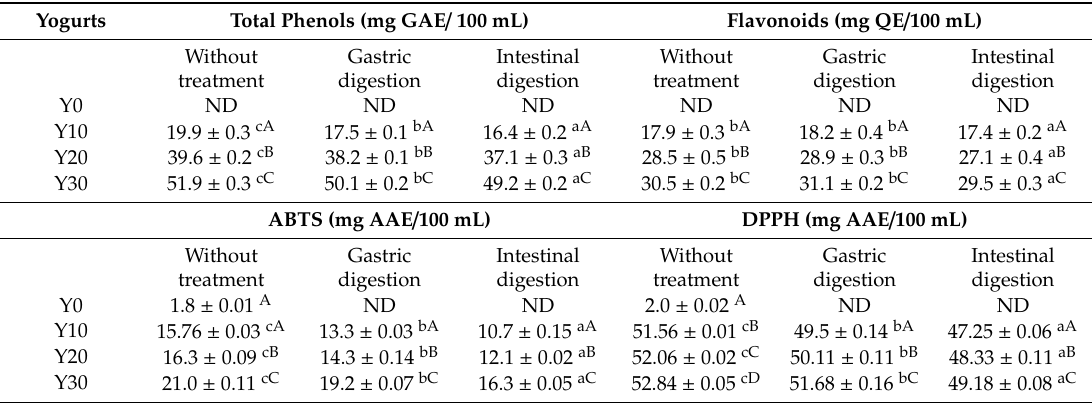
Table 4. Total Phenols, flavonoids and antioxidant activities (ABTS and DPPH) in di ff erent yogurts added with di ff erent % ( w / w ) of multiple emulsions in vitro digestion.